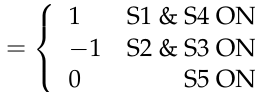
where, m ( t ) = 0 is shown in Figure 3a,c, m ( t ) = 1 is shown in Figure 3b, and m ( t ) = − 1 is shown in Figure